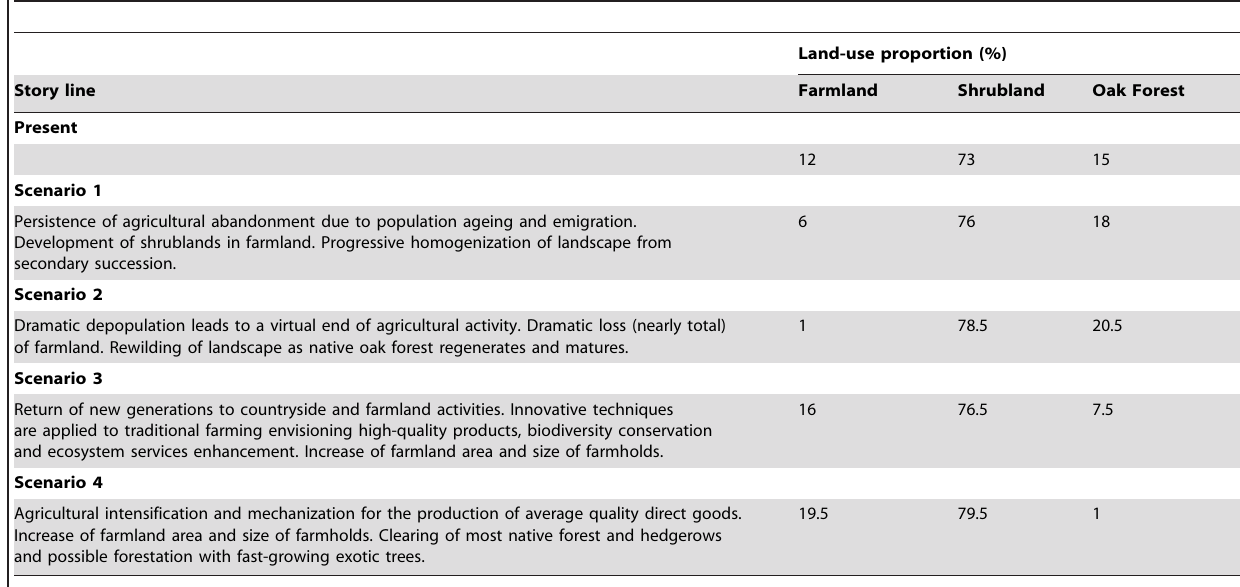
Table 1. Story lines and proportion of area covered by each land-use of four land-use scenarios for the Peneda-Gereˆs National